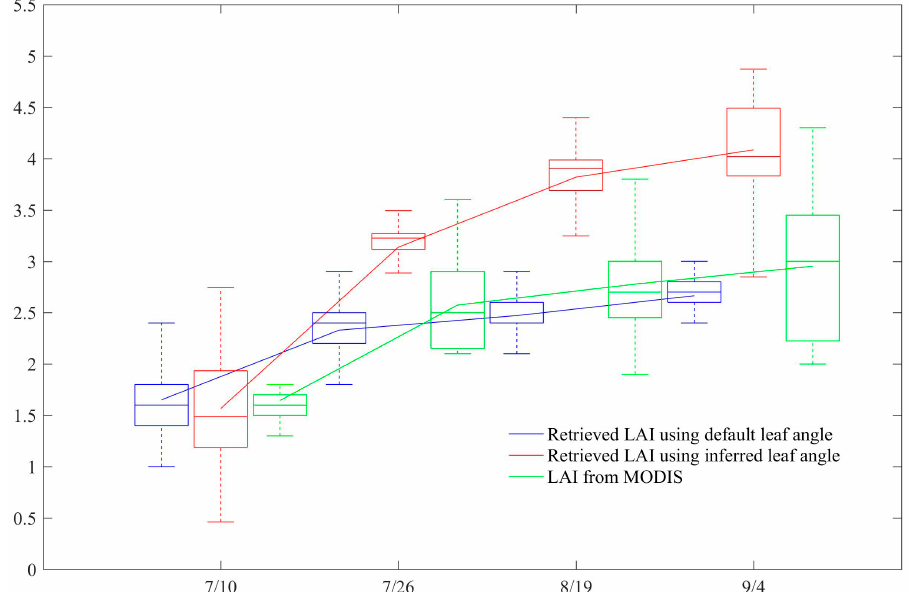
Figure 10. Comparation between the retrieved LAIs with default and inferred leaf angle distribution function on 10 July, 26 July, 19 August, 4 September, 2014, respectively.